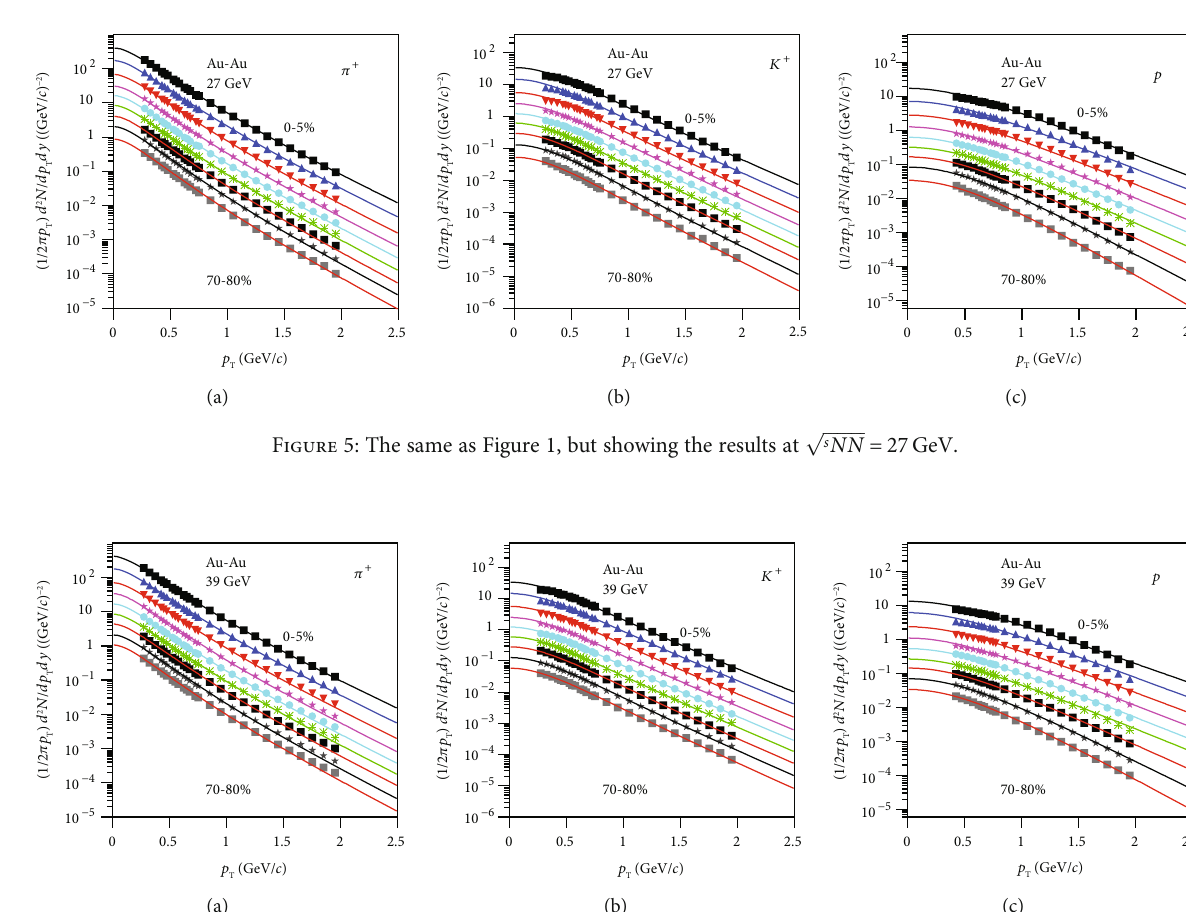
ffiffiffiffiffiffiffiffiffi p = 39 GeV . s NN